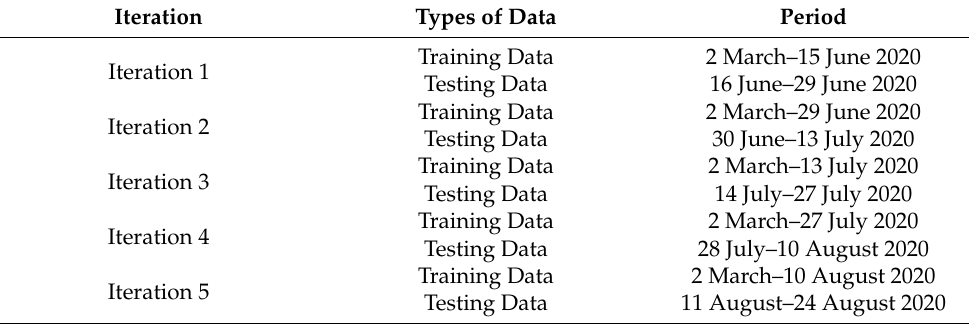
Table 3. Period for long-term testing (forecast).